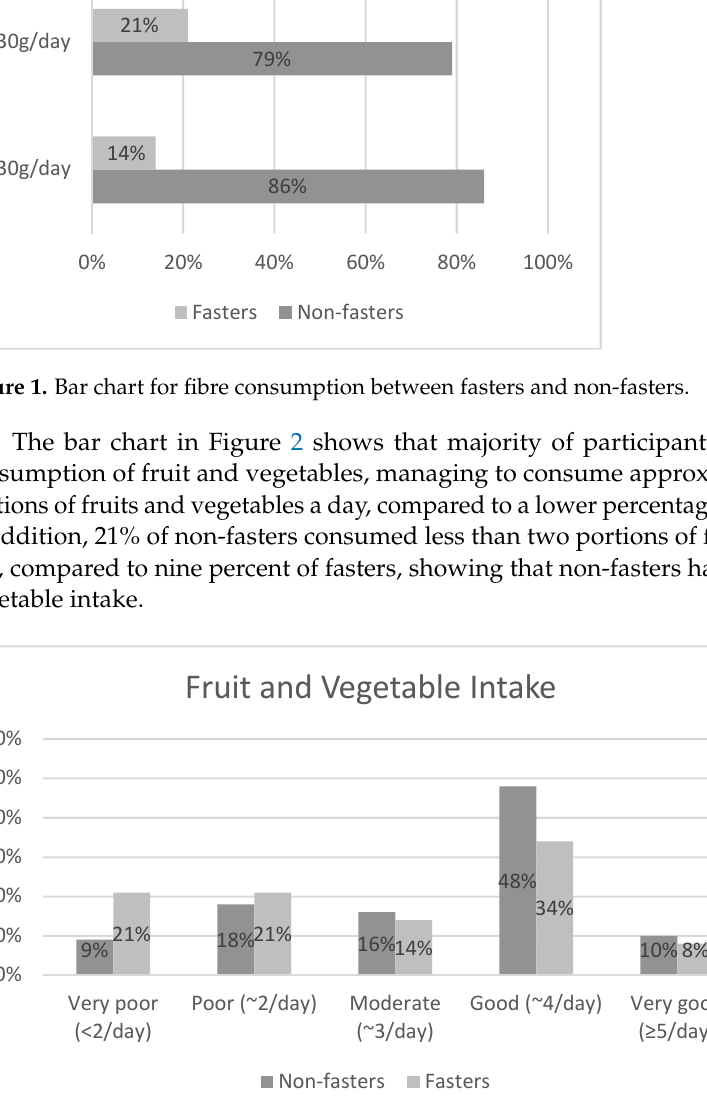
Figure 1. Bar chart for fibre consumption between fasters and non-fasters. Table 2. Dietary fibre intake.